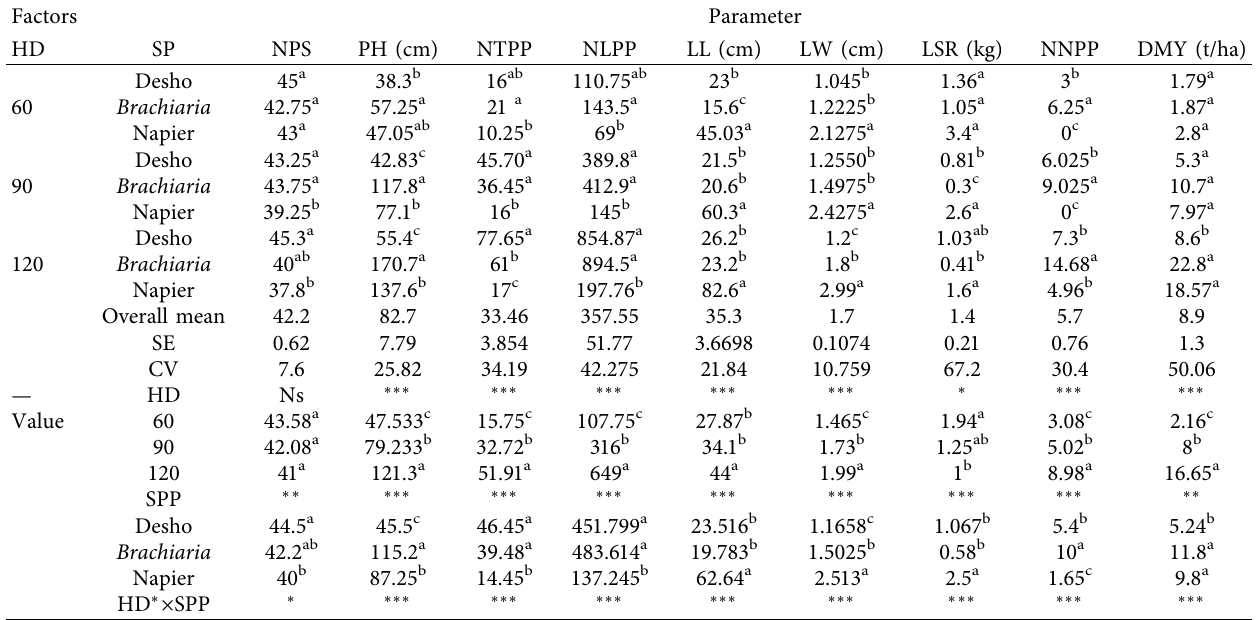
Table 1: Effect of harvesting stage and improved grass species on morphological characteristics and dry matter yield.